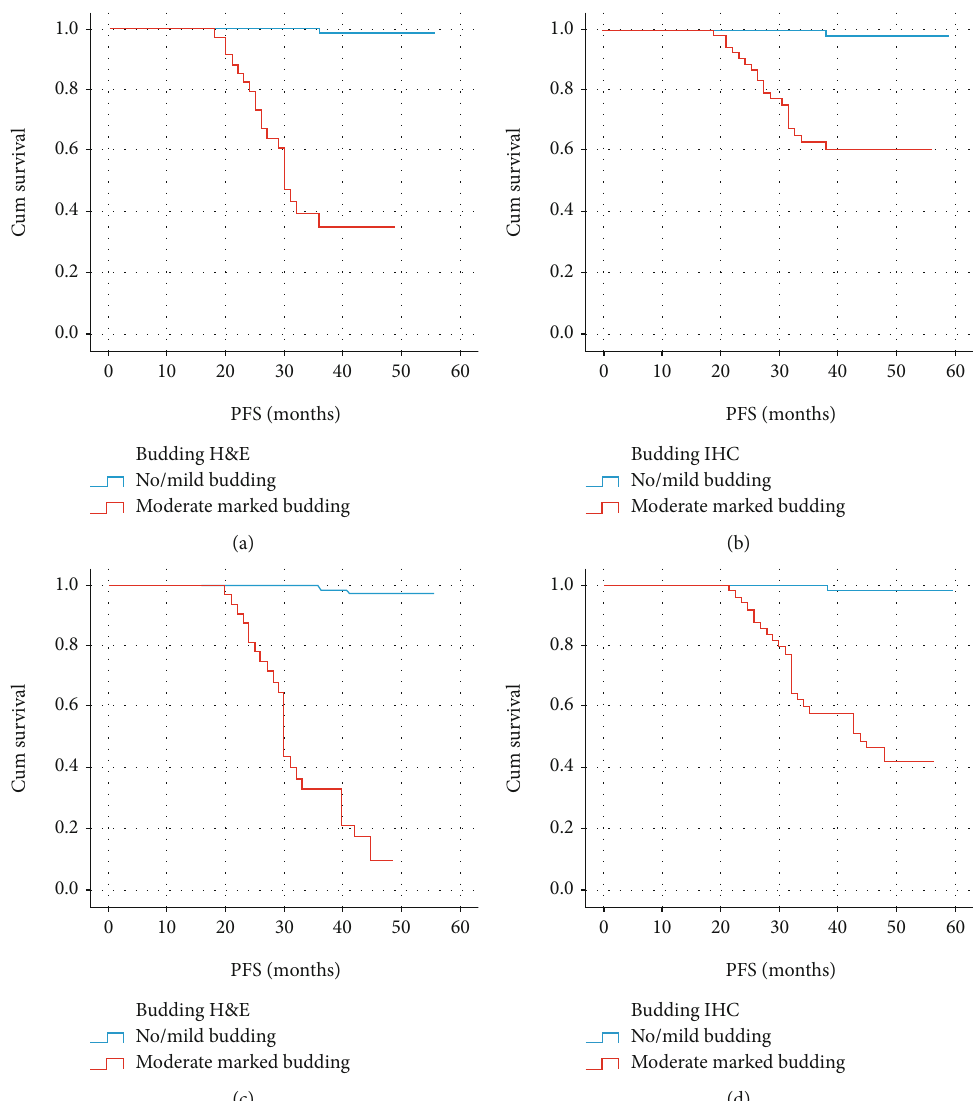
Figure 5: (a) Local recurrence disease-free survival in no/mild (low intensity) budding and moderate/marked (high intensity) budding evaluated by H&E; (b) local recurrence disease-free survival in no/mild (low intensity) budding and moderate/marked (high intensity) budding evaluated by pancytokeratin IHC; (c) distant metastasis-free survival in no/mild (low intensity) budding and moderate/marked (high intensity) budding evaluated by H&E; (d) distant metastasis-free survival in no/mild (low intensity) budding and moderate/marked (high intensity) budding evaluated by pancytokeratin IHC. Table 3: Backward multivariate Cox regression for evaluating the e ff ect of prognostic histopathologic parameters and tumor budding on overall survival. 95% con fi dence interval for HR HR p Sig. Lower Upper Pericapsular invasion 33.906 0.002 HS 3.510 73.515 Vascular invasion 12.759 0.000 HS 3.133